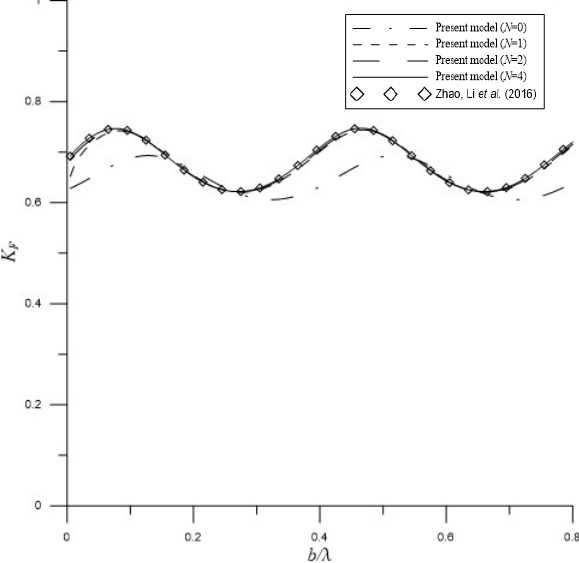
Figure 3. Dimensionless wave force varying against dimensionless breakwater width for scattering of incident waves by a rectangular structure placed near a partially reflecting vertical wall [35].